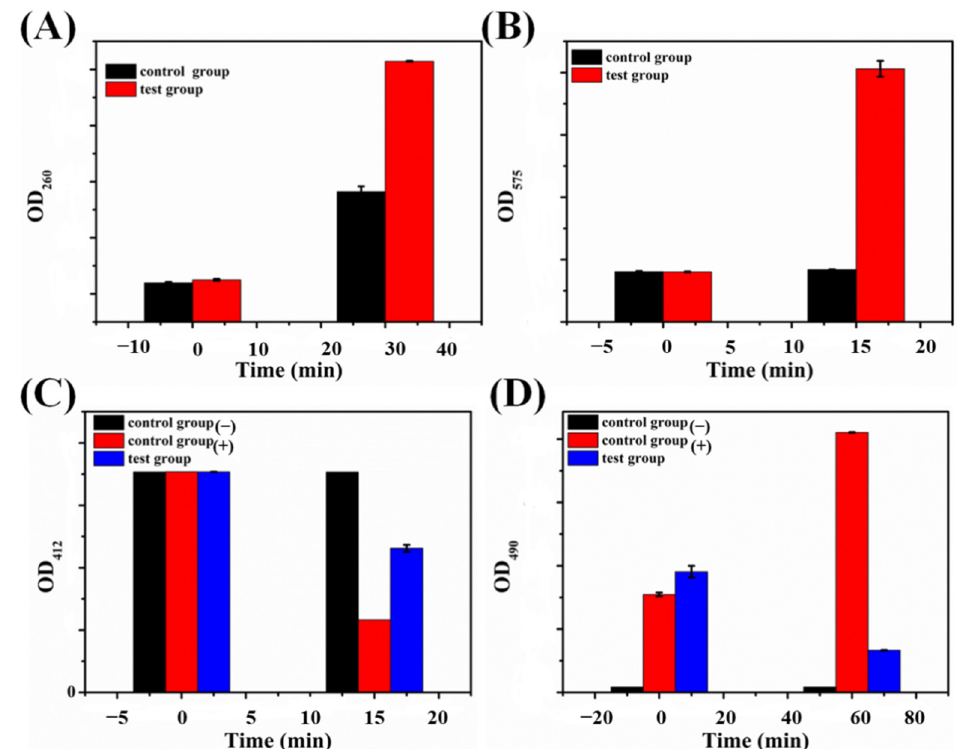
Figure 9. ( A ) Intracellular constituents of RNA leakage of E. coli at 260 nm. ( B ) Protein leakage of E. coli at 595 nm. ( C ) GSH oxidation at 412 nm induced by 1. ( D ) The respiratory chain dehydrogenase activity of E. coli at 490 nm; parallel experiments were performed (mean ± SD, n = 3).